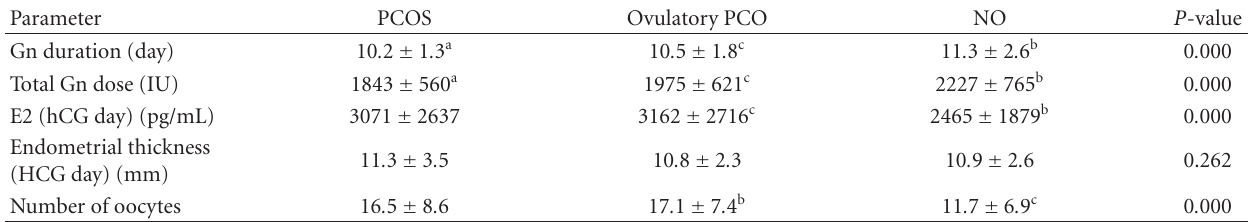
Table 2: Comparisons of controlled ovarian hyperstimulation (mean ±